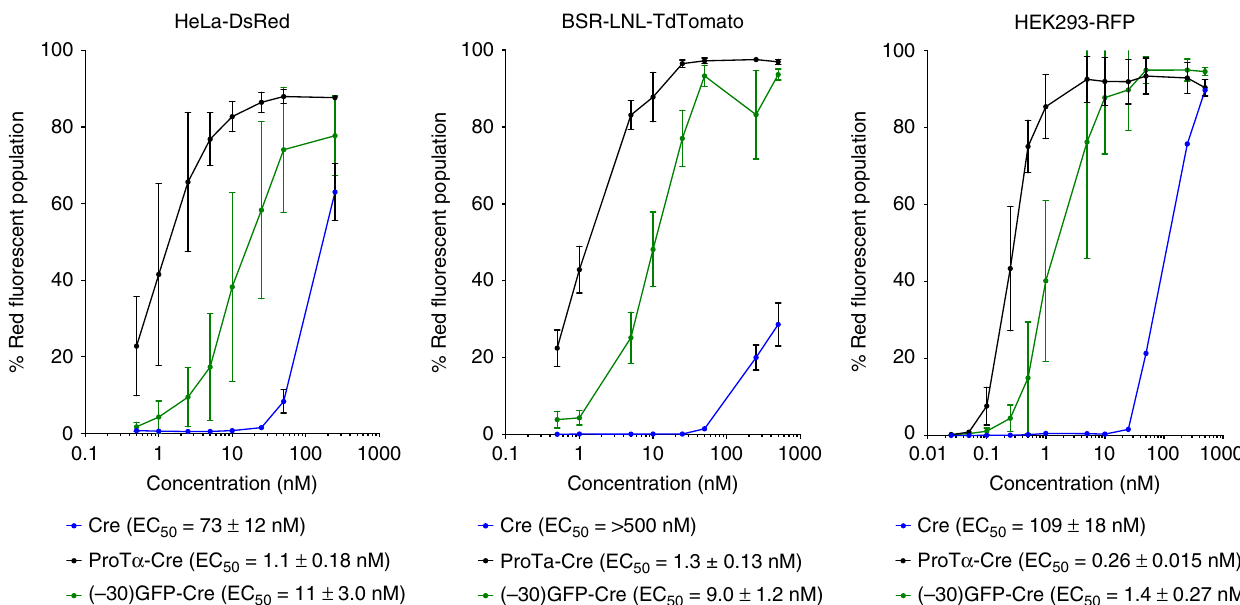
Fig. 1 ProT α enables ef fi cient cationic lipid-mediated protein delivery into HeLa-DsRed, BSR-tdTomato, and HEK293-RFP cell lines. EC 50 is de fi ned as the protein concentration at which 50% of analyzed cells contain red fl uorescence. In all cell lines tested, ProT α delivers Cre at low nM concentrations, ~10-fold more potent than ( – 30)GFP and ~100-fold more ef fi cient than unmodi fi ed Cre. Values and error bars represent the mean and standard deviation of three independent biological replicates performed on different days. EC 50 values were determined by nonlinear fi t to the Hill equation, and are followed by the standard errors of the fi t. Source data are available in the Source Data fi